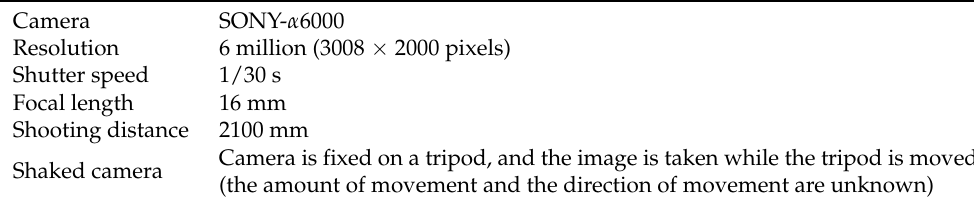
Table 17. Shooting condition of a shaked